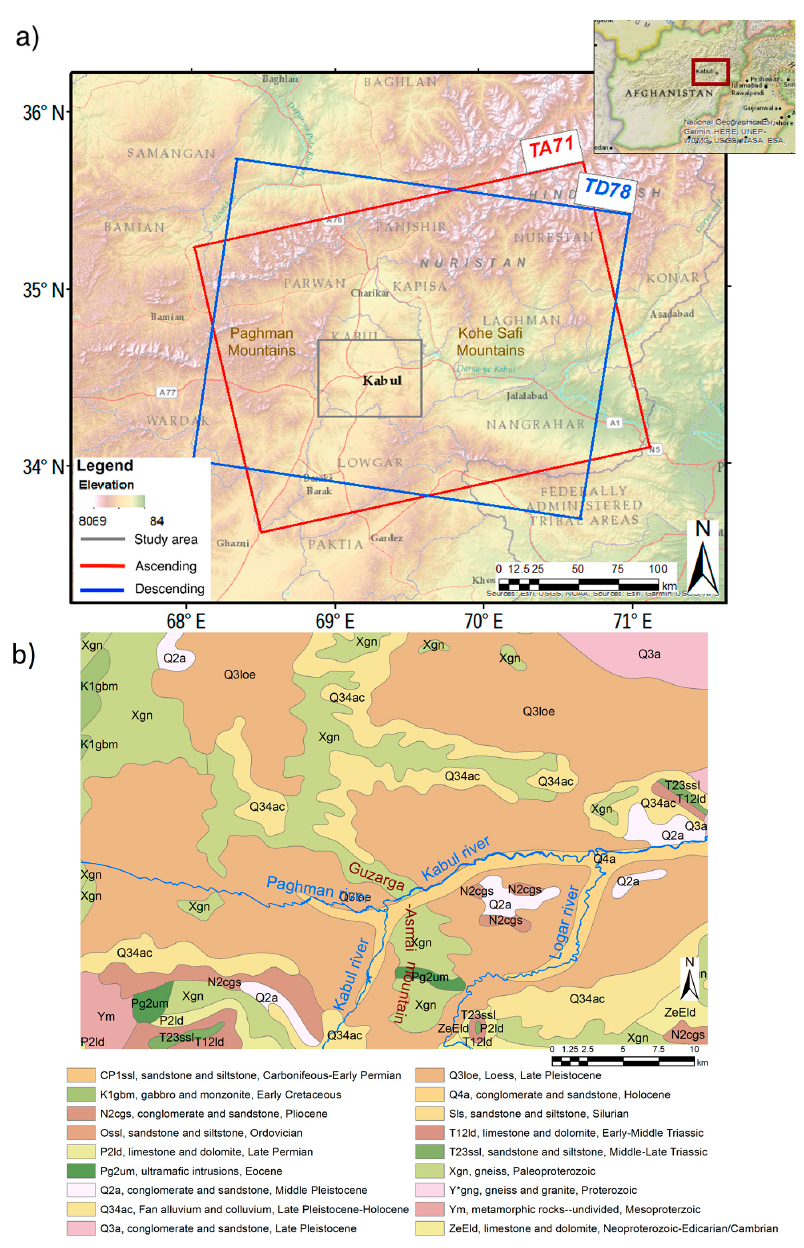
Figure 1. ( a ) Location map of the study area. Blue and red rectangles outline the footprints of ascending and descending Sentinel-1 SAR datasets indicated as TA71 and TD78, respectively. The grey frame shows the area of reconstructed 2D surface deformation field. ( b ) The geological map of the study area corresponding to the grey frame